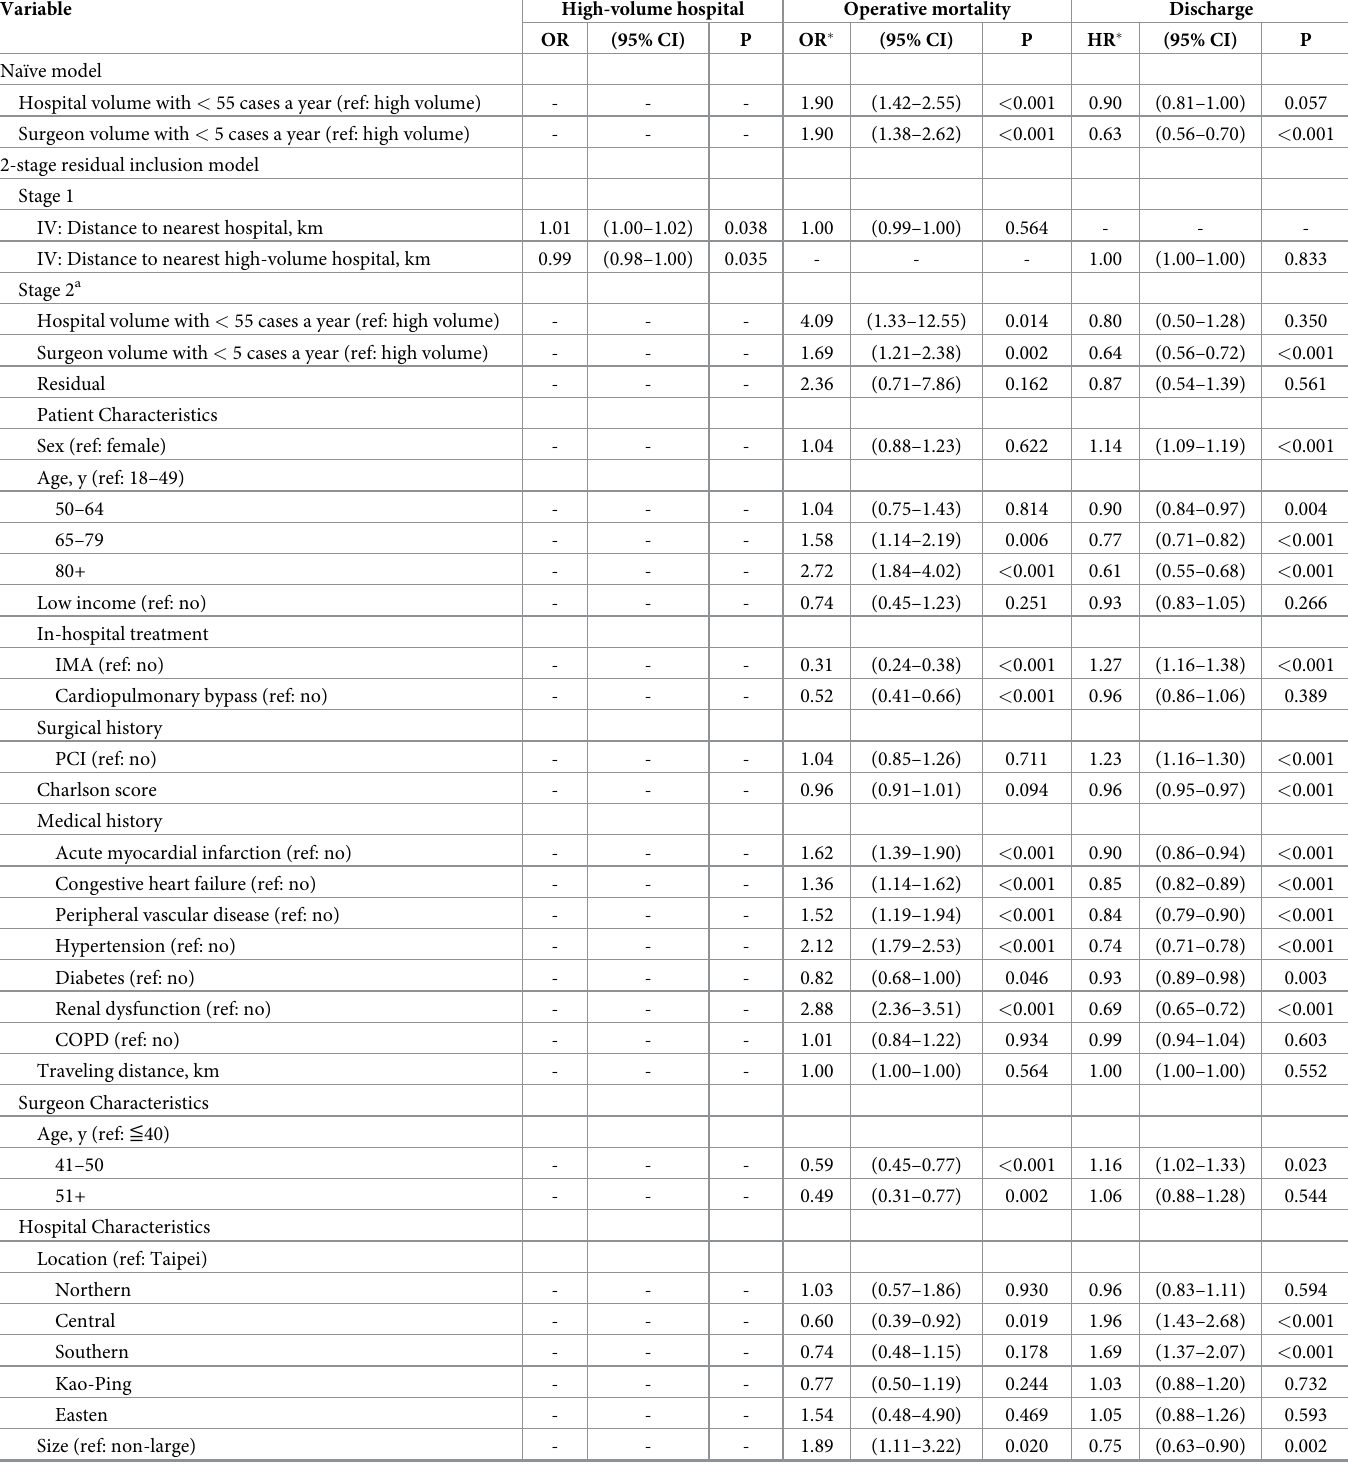
Table 4. The first stage regression of instrumental variable model and the effects of hospital volume and surgeon volume on operative mortality and discharge.